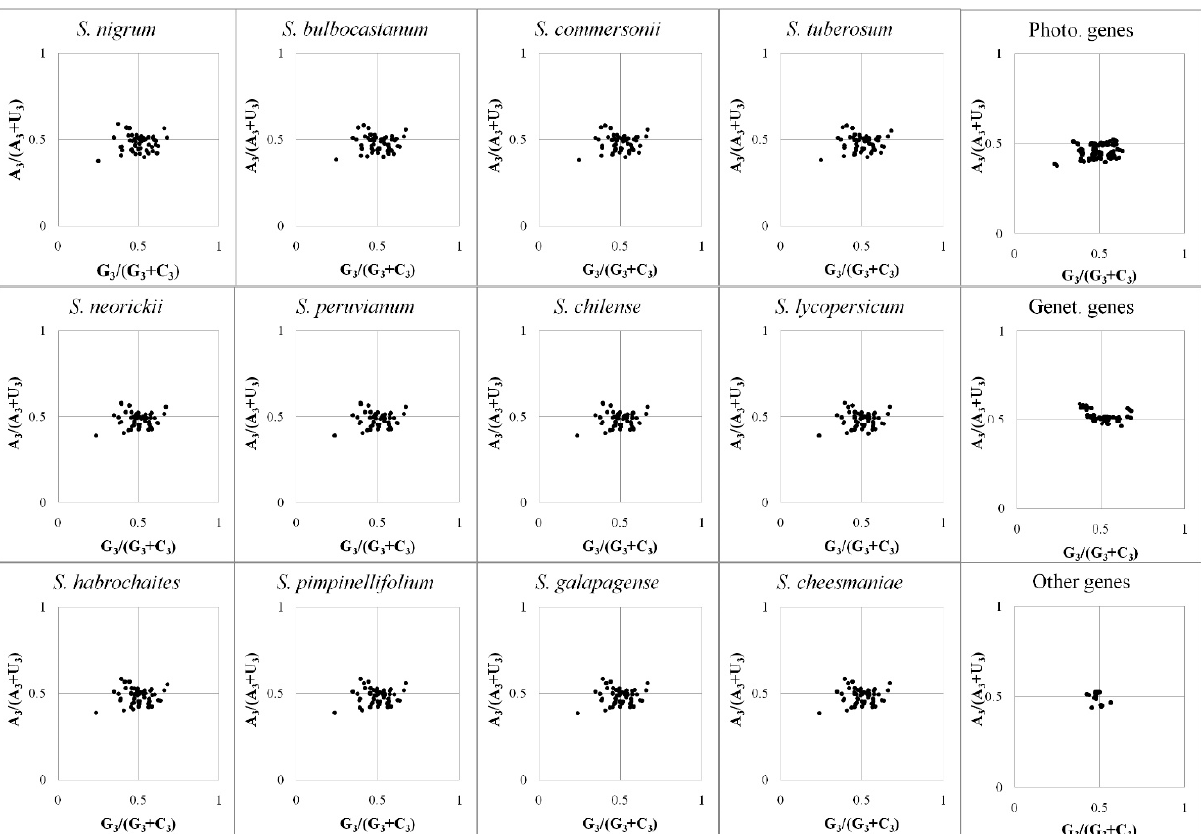
Figure 5. The PR2-bias plots of Solanum chloroplast genomes. Genes were plotted based on their GC bias [G 3 /(G 3 + C 3 )] and AU bias [A 3 /(A 3 + U 3 )] in the third codon position. The mean GC-biases of S. nigrum , S. bulbocastanum , S. commersonii , S. tuberosum , S. neorickii , S. peruvianum , S. chilense , S. lycopersicum , S. habrochaites , S. pimpinellifolium , S. galapagense , S. cheesmaniae , Photo-genes, Genet-genes, and Other genes were 0.497, 0.498, 0.499, 0.498, 0.497, 0.498, 0.497, 0.497, 0.497, 0.496, 0.497, 0.497, 0.482, 0.515, and 0.513, respectively; while their mean AU-biases were 0.484, 0.484, 0.483, 0.484, 0.486, 0.486, 0.486, 0.485, 0.486, 0.486, 0.486, 0.486, 0.461, 0.519, and 0.487, respectively. The GC bias of 0.482 and AU bias of 0.461 showed a stronger preference of pyrimidines over purines for Photo-genes, whereas the GC bias of 0.515 and AU bias of 0.519 showed a preference of purines over pyrimidines for Genet-genes.